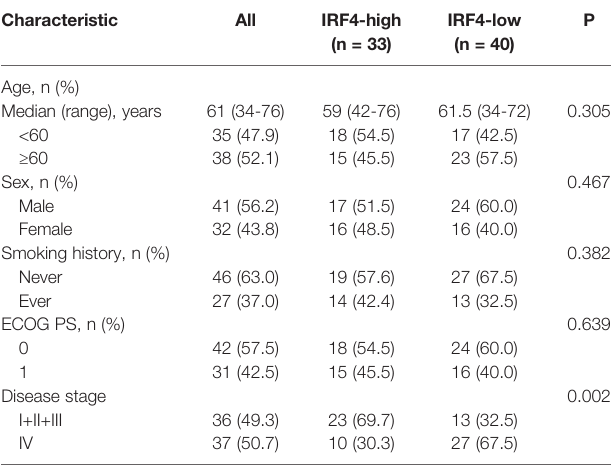
TABLE 2 | Clinical characteristics of lung adenocarcinoma patients with IRF4- high and low expression. Characteristic